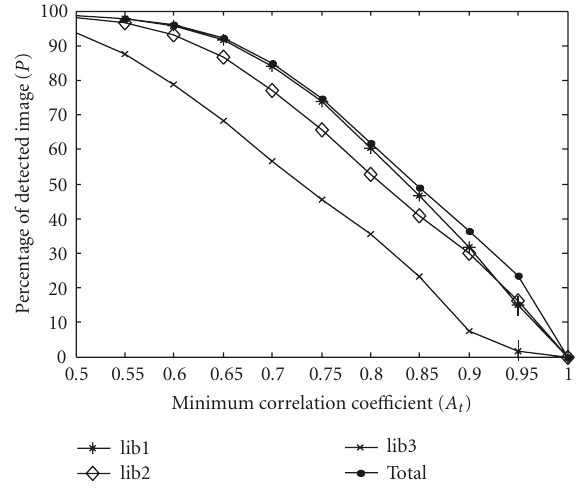
Figure 8: Result of detected image when clustered bands are used in the detection. Bands used are (27, 28, 29,